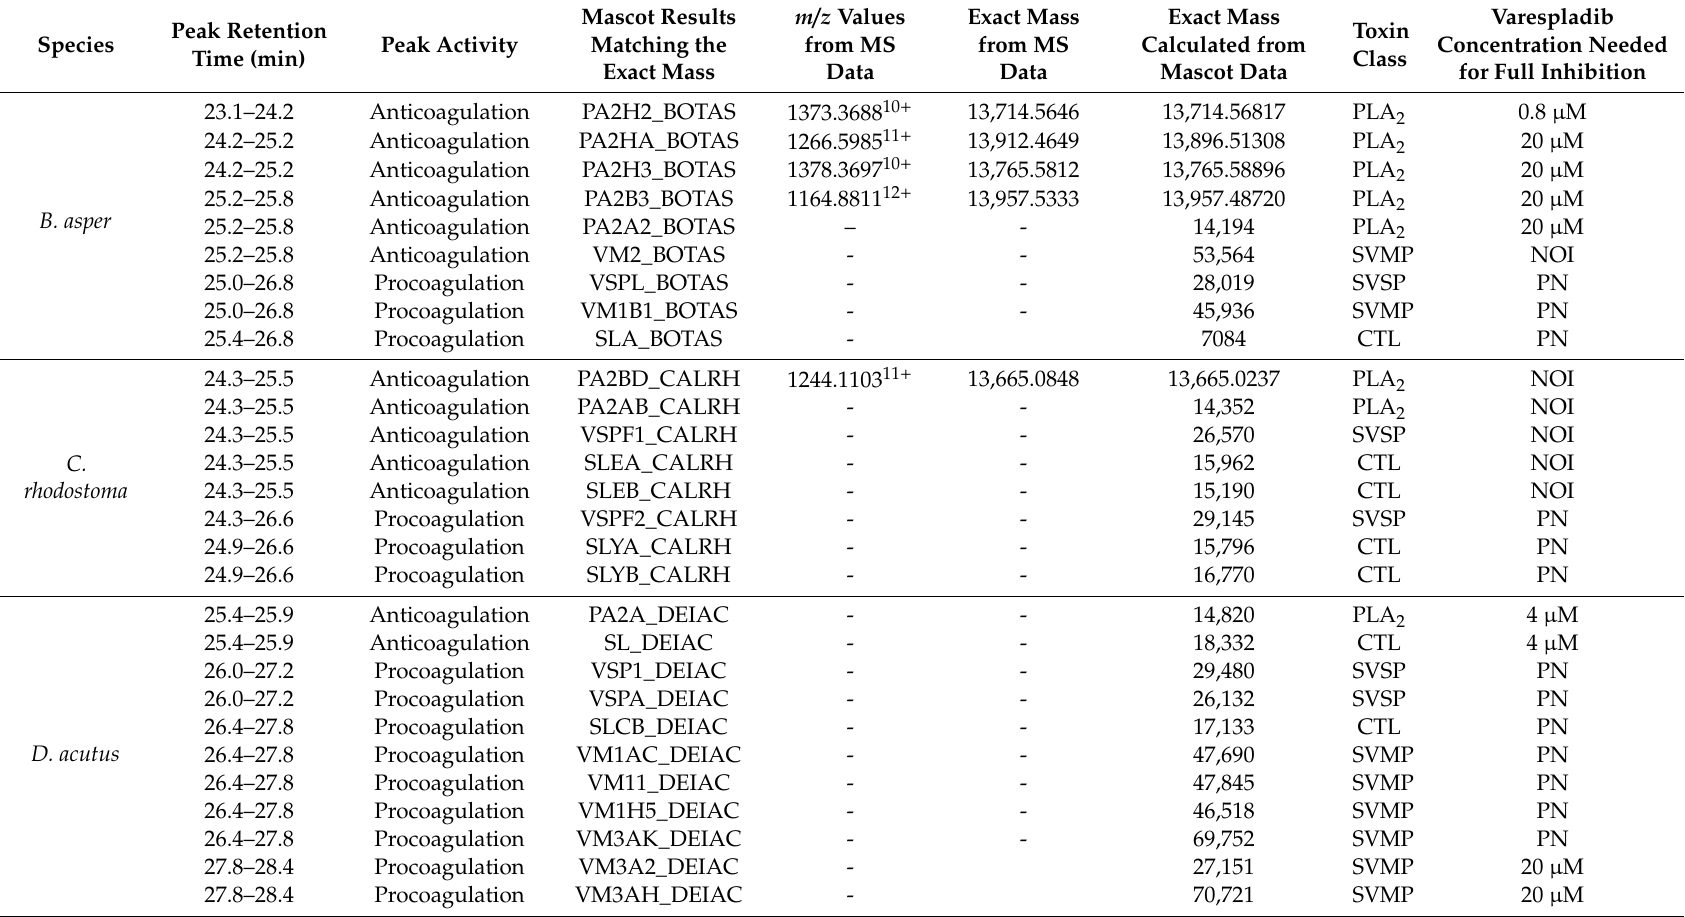
Table 2. Part 1 —Correlated LC-MS masses and proteomics data for coagulopathic venom toxins activities (peak retention times are adapted from Figure 4; SVMP: Snake Venom Metalloproteinase; SVSP: Snake Venom Serine Protease; CTL: C-Type Lectin; kunitz: kunitz-type serine protease inhibitor; PN: Partly Neutralized at 20 µ M varespladib; NOI: No Observed Inhibition. (table continues on next